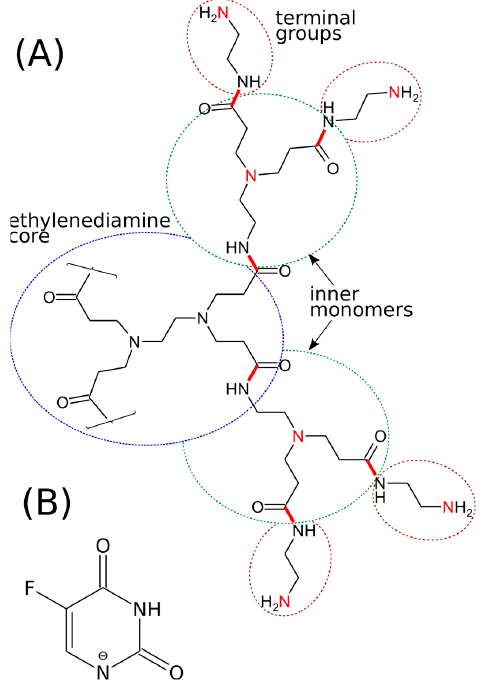
Figure 8. ( A ) Schematic illustration of chemical linkages in the first-generation PAMAM dendrimers. Higher-level generations can be built by repeating inner monomer units. Red sticks denote the linkage between core, inner monomers, and terminal groups, while red N atoms denote nitrogen atoms which can be protonated. ( B ) Chemical structure of the anionic form of the 5-fluorouracil molecule used in simulations.